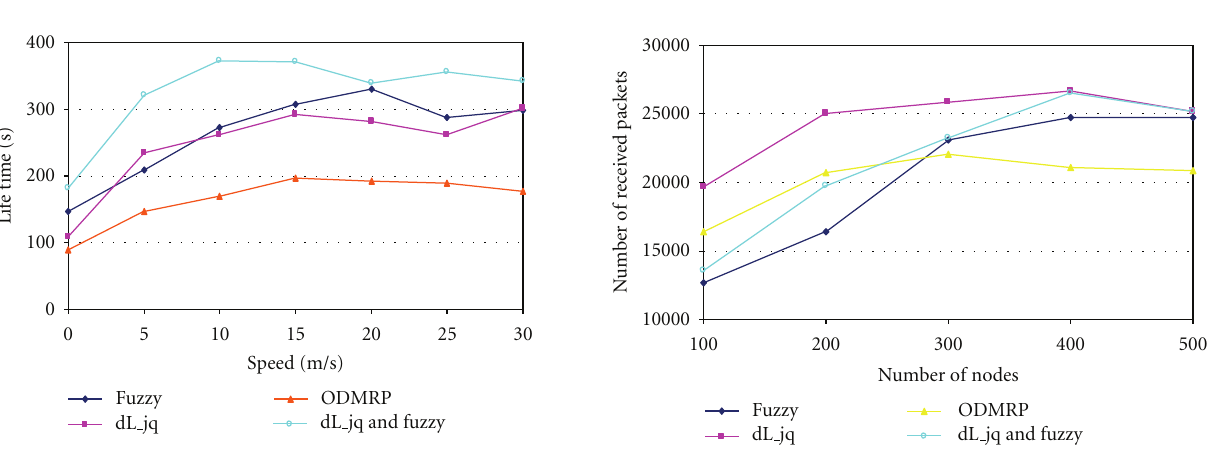
Figure 13: Number of received packets with increasing number of